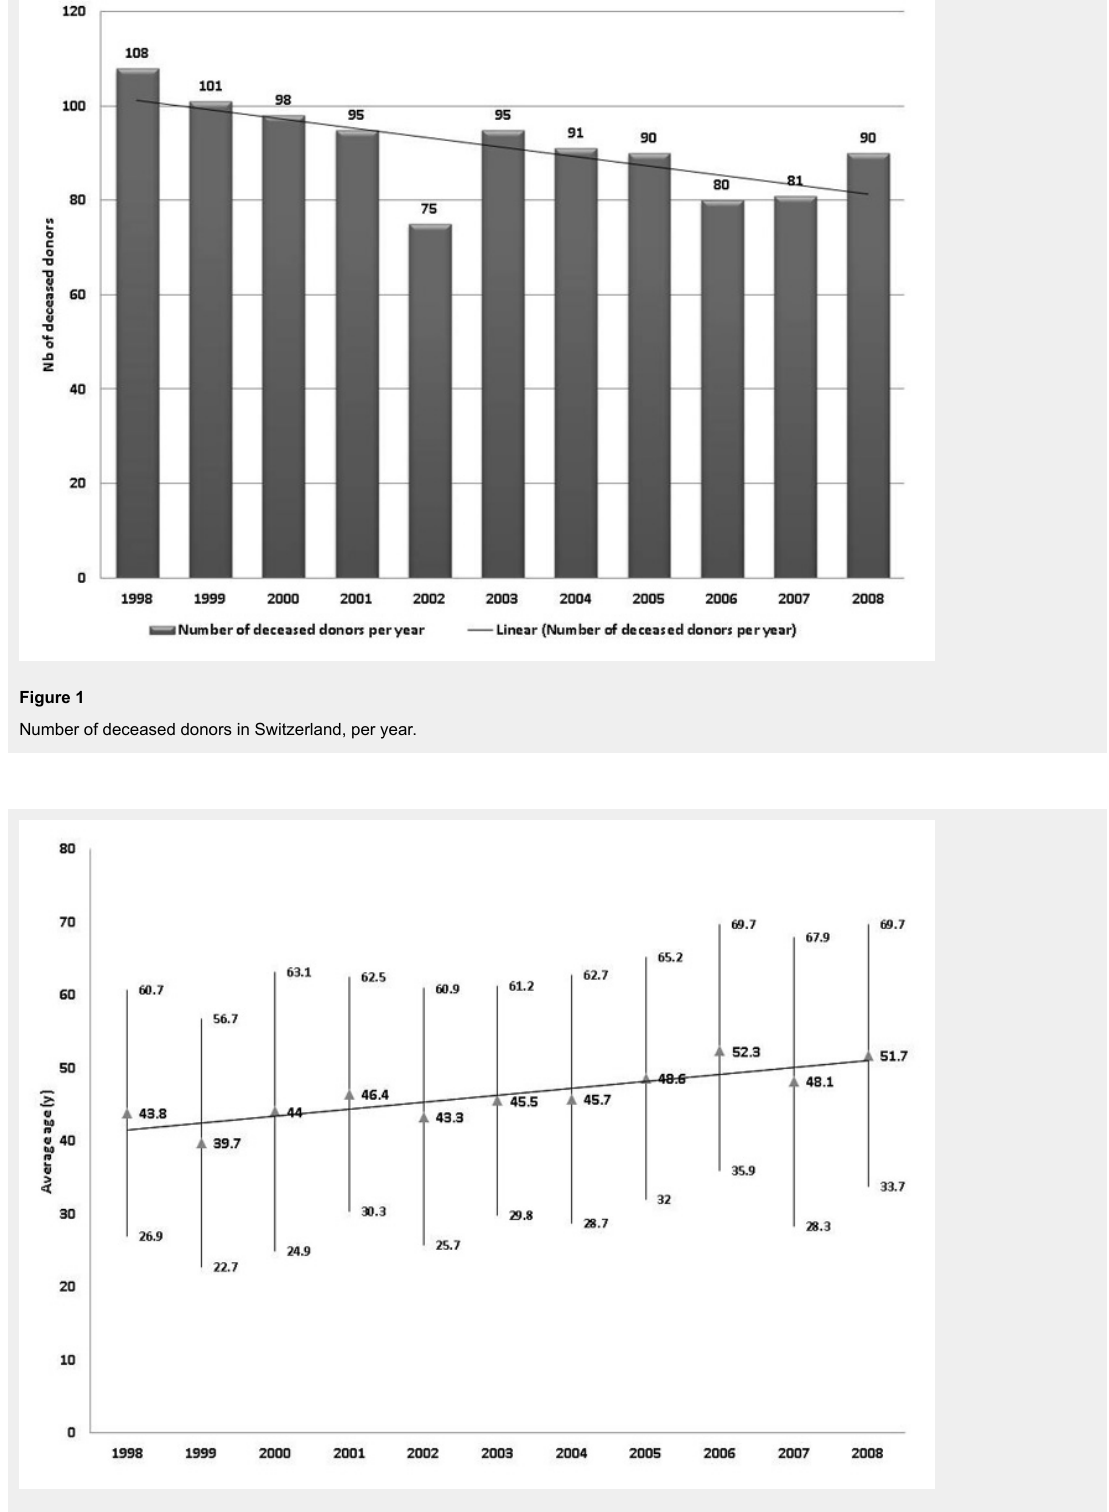
Figure 2 Average age (in years) of the deceased donors per year, displaying ±1.SD (standard deviation) and linear